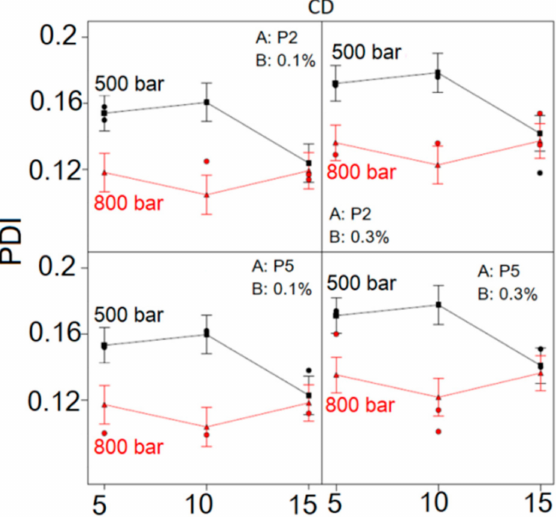
Figure 3. Interaction graphs for the polydispersity index (PDI) of designed placebo nanoemulsions; P2-PEG2000-DSPE;